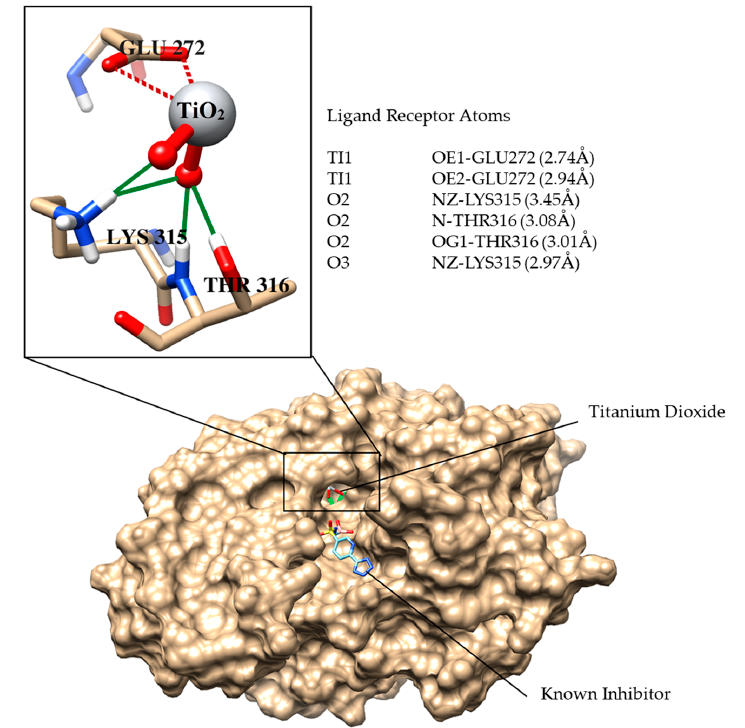
Figure 19. The binding mode of the known inhibitor (shown in cyan stick model) and TiO 2 is shown in the active site of E. coli β -lactamase. The binding residues are presented in a tan stick model, Hydrogen bonds are demonstrated in green lines, metallic interactions between ligand and Glu272 are depicted in maroon dashed lines. The bond lengths between ligand and the interacting atoms of residues are written in parenthesis .